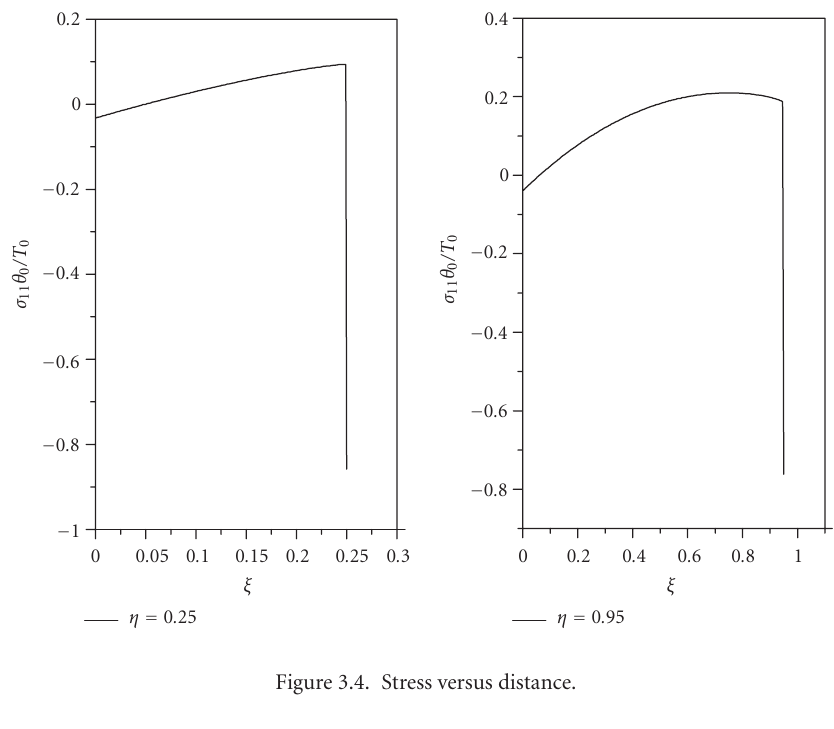
Figure 3.4. Stress versus